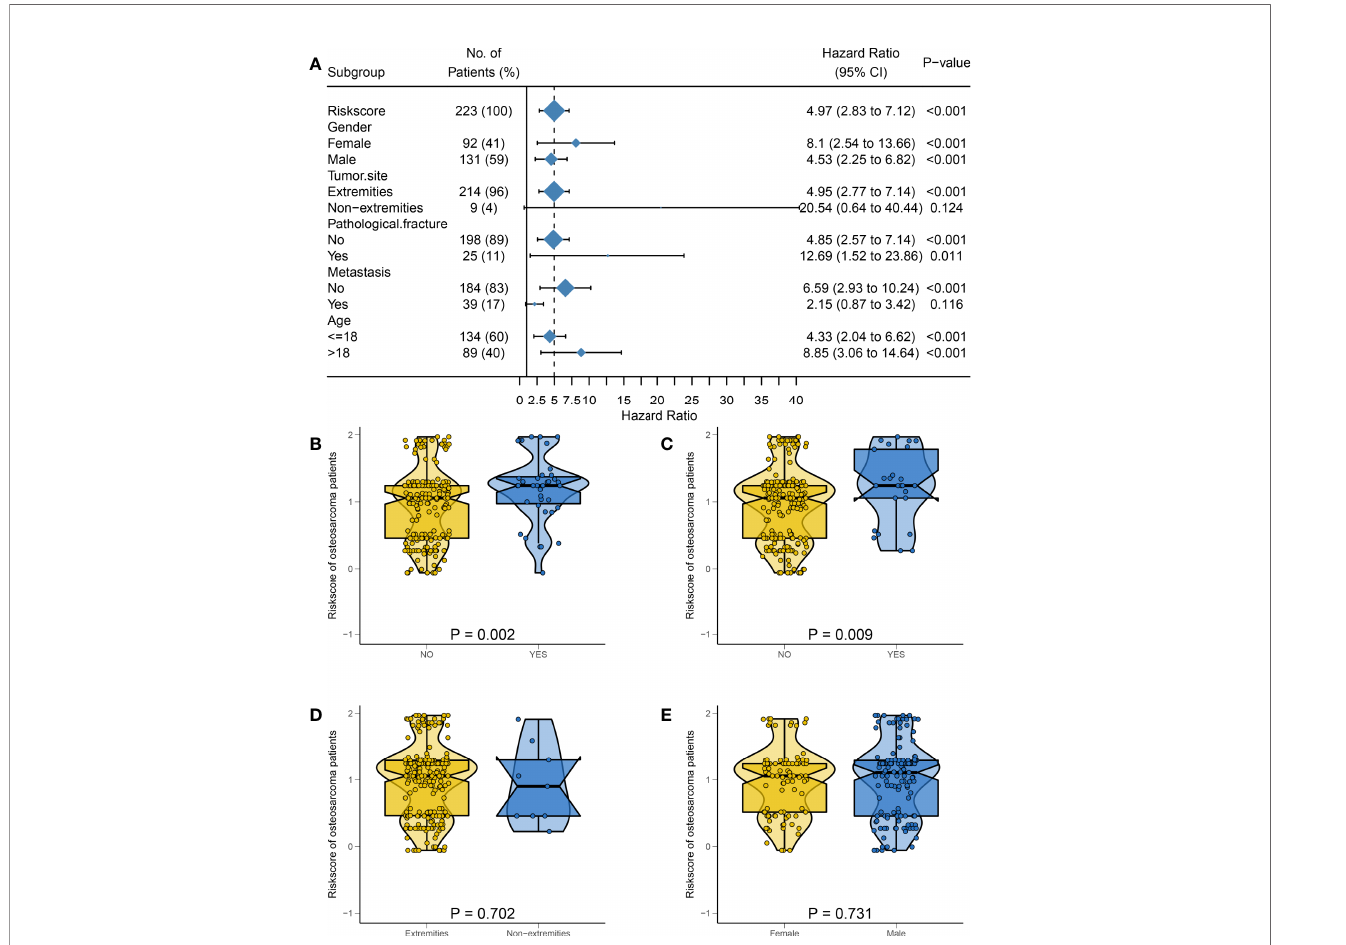
FIGURE 5 | The predictive power of HPSS in subgroups and the relationship between HPSS and clinical characteristics were assessed. (A) A forest plot showing the predictive power of HPSS in each subgroup, it can be seen that HPSS has limited predictive power in patients with tumor metastasis and non-extremity groups; (B) The relationship between HPSS and tumor metastasis status; (C) The relationship between HPSS and pathological fracture status; (D) The relationship between HPSS and tumor location; (E) The relationship between HPSS and